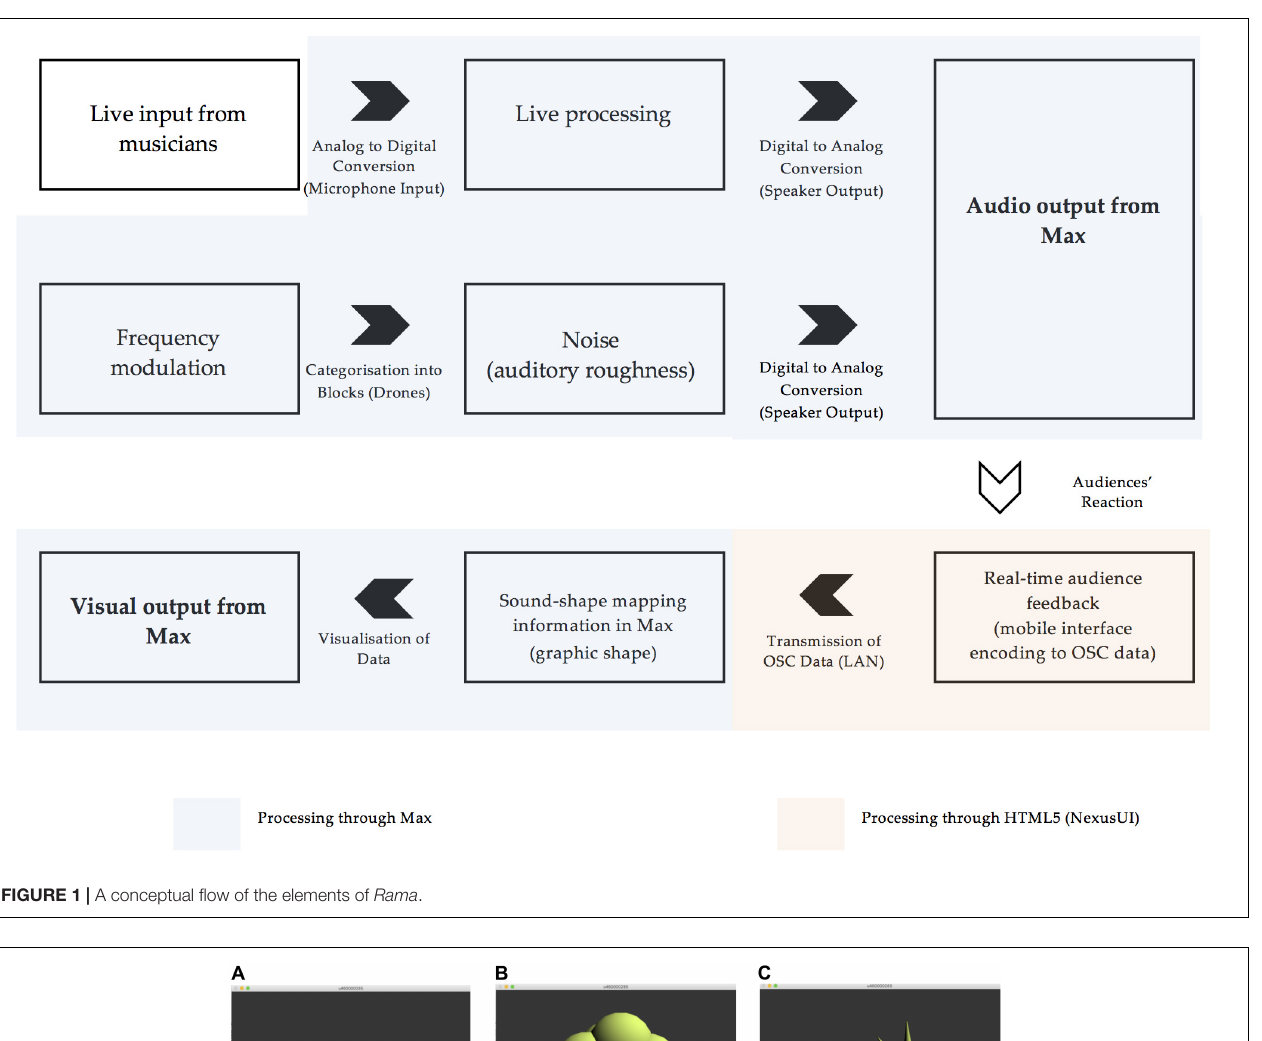
FIGURE 1 | A conceptual flow of the elements of Rama .